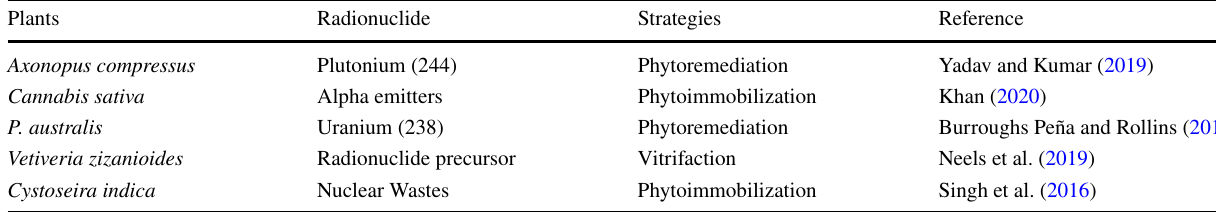
Table 6 Phytoremediation of radionuclides